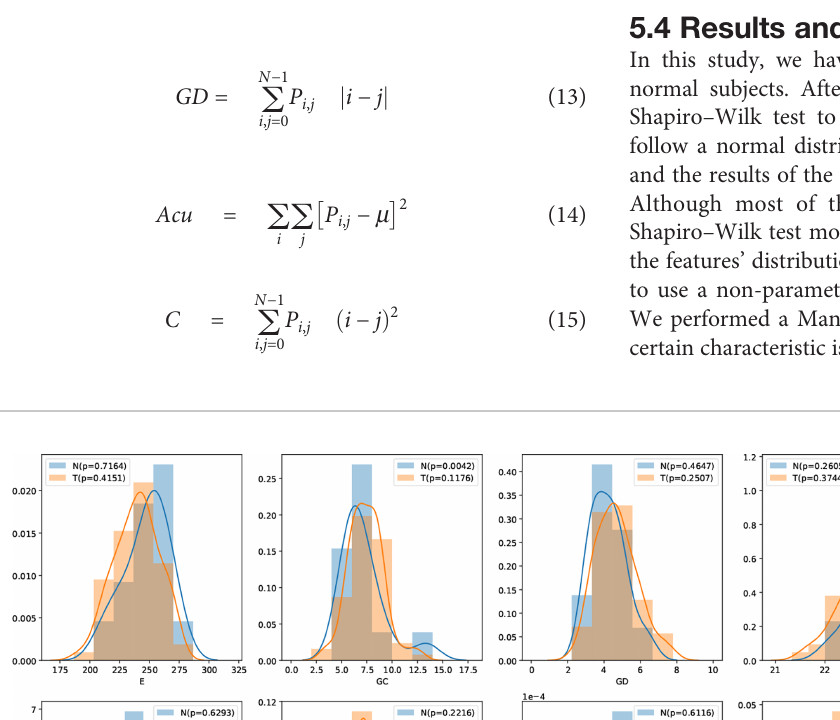
FIGURE 7 | Correlation matrix with Pearson correlation coef fi cient of the 10 features. E, entropy; GC, gray-level co-occurrence matrix contrast; GD, gray-level co- occurrence matrix dissimilarity; GH, gray-level co-occurrence matrix homogeneity; S, entropy; GM, gray mean; GS, gray standard deviation; C, contrast; Acu, sharpness of image edges.